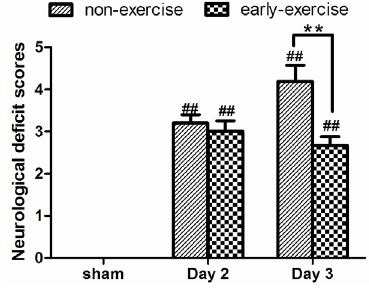
Figure 1. Effect of early exercise on neurological outcomes. Middle cerebral artery occlusion (MCAO) caused marked neurological deficits, but the early-exercise group had significantly lower neurological scores after three-days’ exercise, indicating improvement. ** p < 0.01 compared with the non-exercise group. ## p < 0.01 compared with the sham group. Data represent the mean ± SE. n =